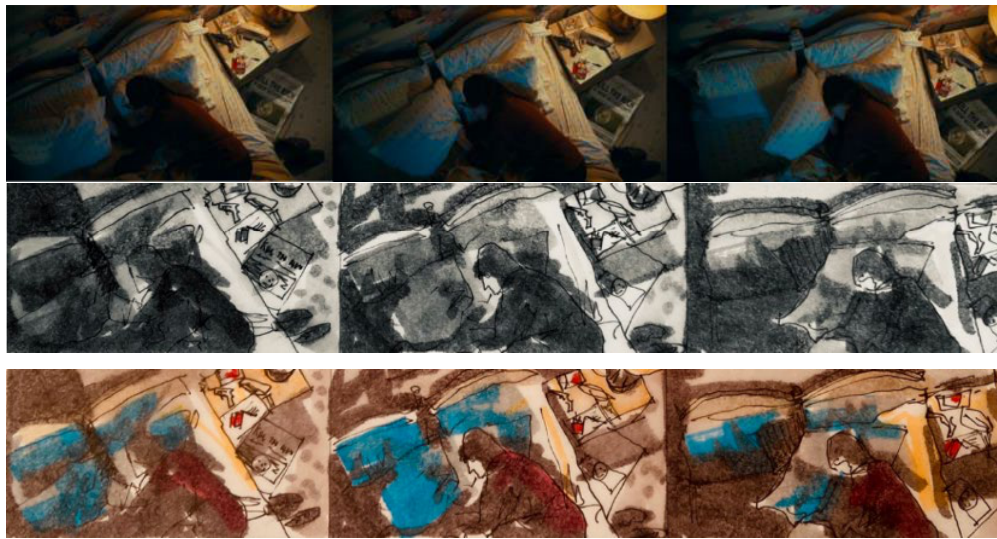
Figures 24-26 Overhead shots: Analysis of sequence through contrast and colour. Mother’s